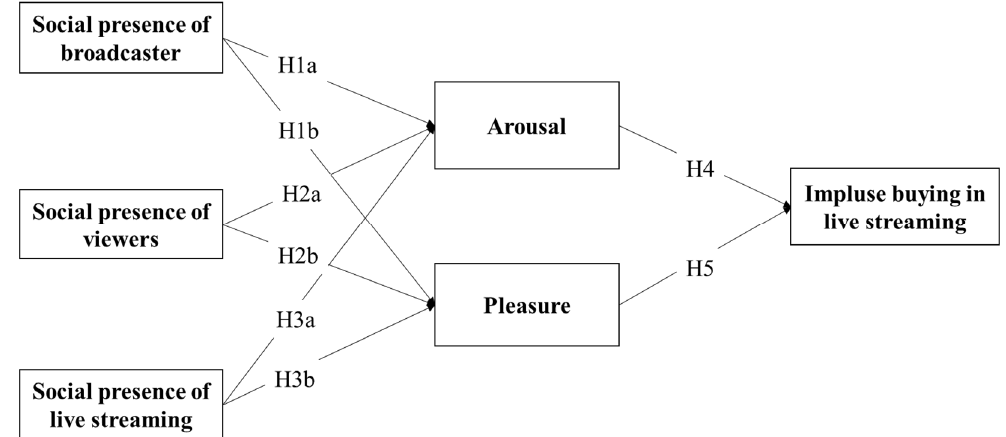
Figure 1. Our research model.